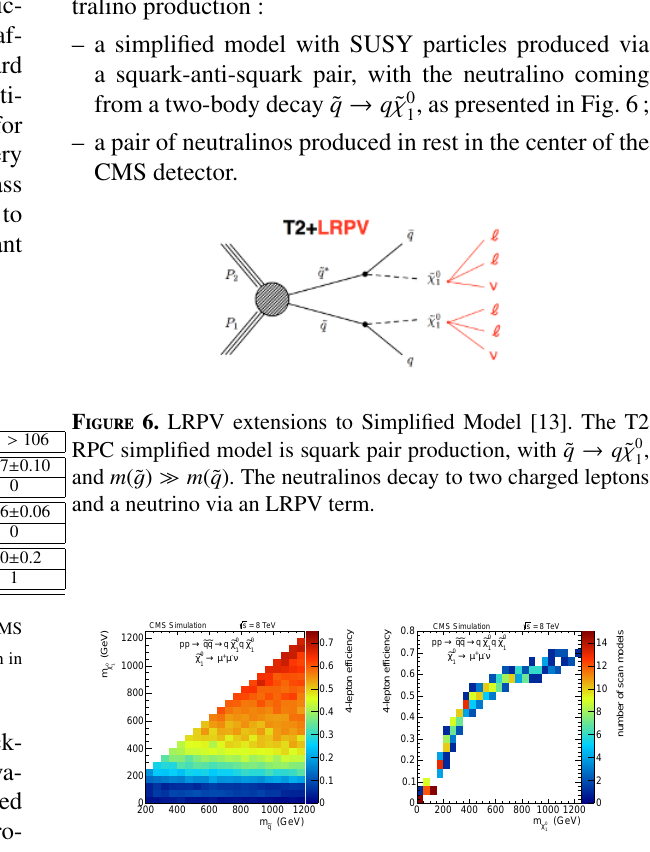
F igure 7. Left : e ffi ciency for the T2 + LRPV model. ˜ χ 0 Right : For every neutralino mass the e ffi ciency value is filled corresponding to the di ff erent squark